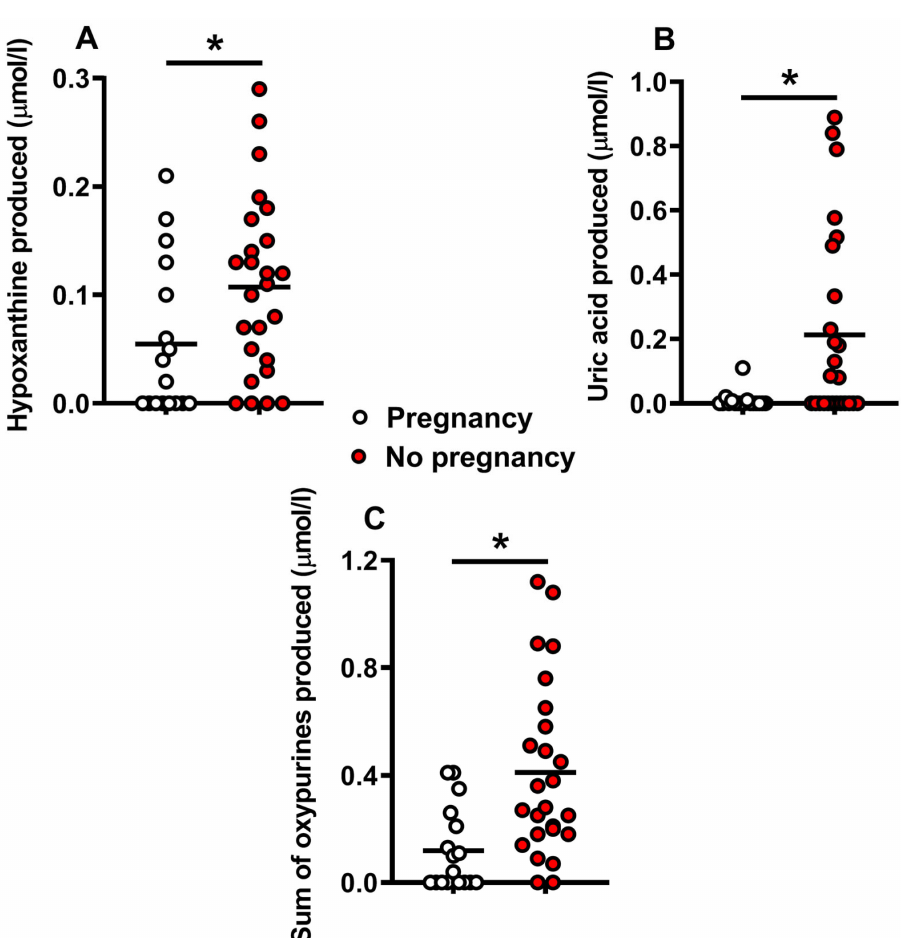
Figure 3. Concentrations of hypoxanthine ( A ), uric acid ( B ), and the sum of oxypurines ( C ) de- tected in culture media of human embryos at 5 days post-fertilization. Embryos were divided into those with successful (n = 17, empty circles) or unsuccessful pregnancy (n = 25, red filled cir- cles), independently on the embryo grade. The mean values are represented by the horizontal bars. Sum oxypurines = hypoxanthine + uric acid. * Significantly different from high grade, q < 0.02 ( A ), q < 0.01 ( B ), and q < 0.0005 ( C